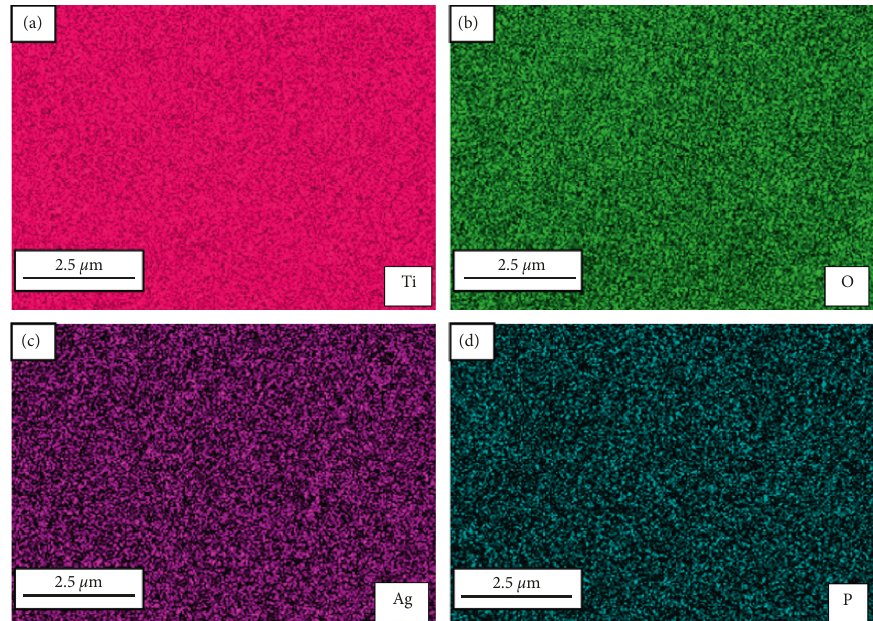
Figure 4: EDS elemental maps of TiO 2 NT disk treated with Ag 3 PO 4 followed by irradiation using Xe lamp. The elements represent (a) titanium, (b) oxygen, (c) silver, and (d) phosphorus.